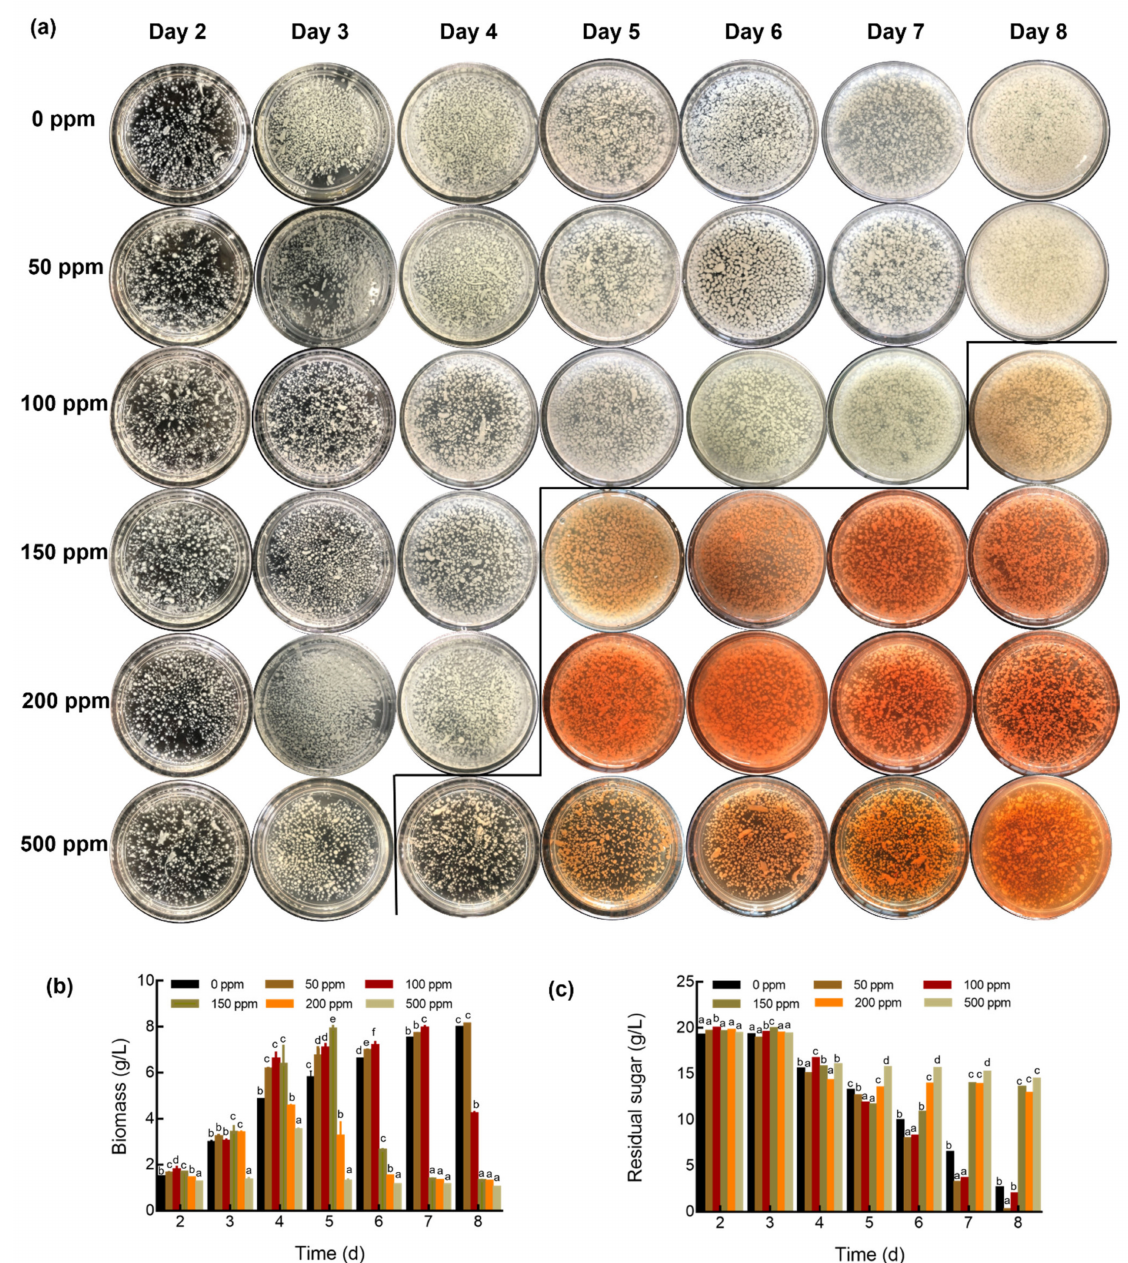
Figure 1. Morphology ( a ), biomass ( b ), and residual sugar ( c ) content of Ganoderma lucidum in the liquid culture process. The bars indicate the standard error of the mean (different letters indicate a significant difference on the same culture day at p <